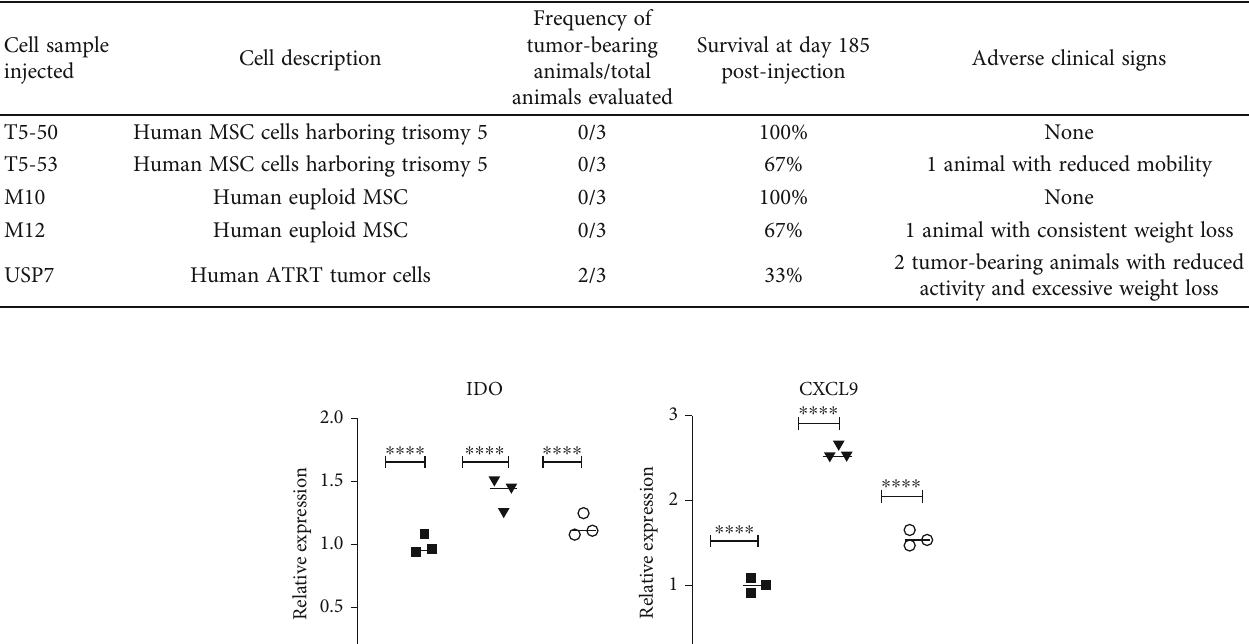
Table 2: Tumor incidence, overall survival, and adverse signs in nude mice after 185 days of subcutaneous injection of MSC or tumor cells. Animals Survival after cell inoculation (p =0.2247).